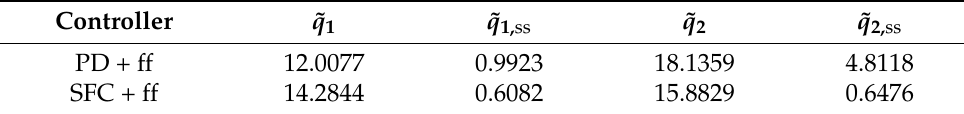
Table 5. Position Error RMS comparative of the simulation results for ˜ q with F C .